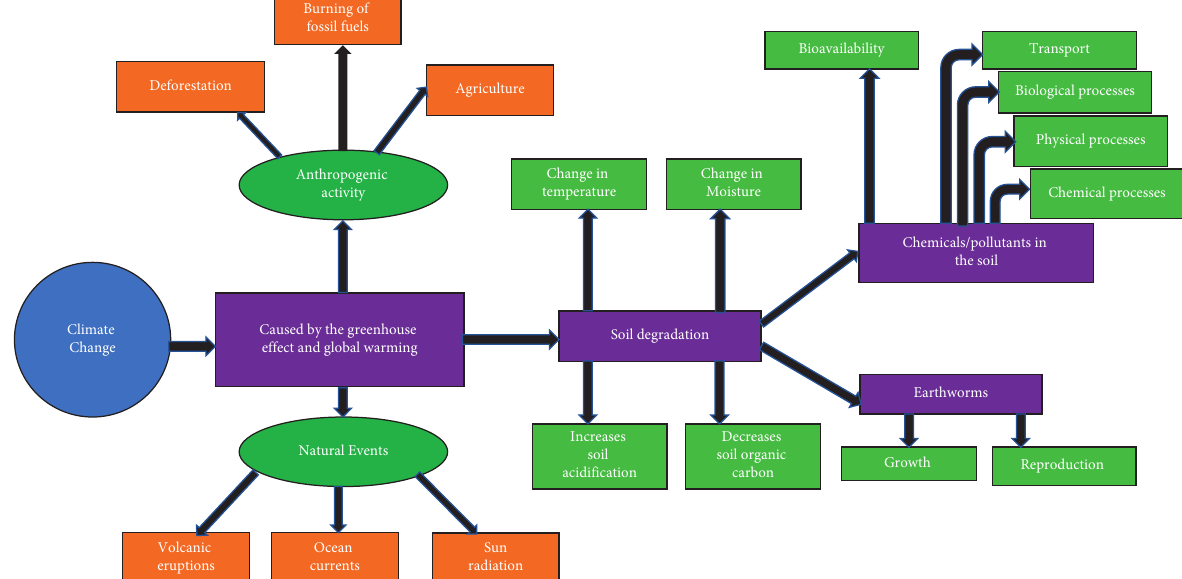
Figure 3: Fate and behaviour of pesticides towards earthworms under the influence of climate